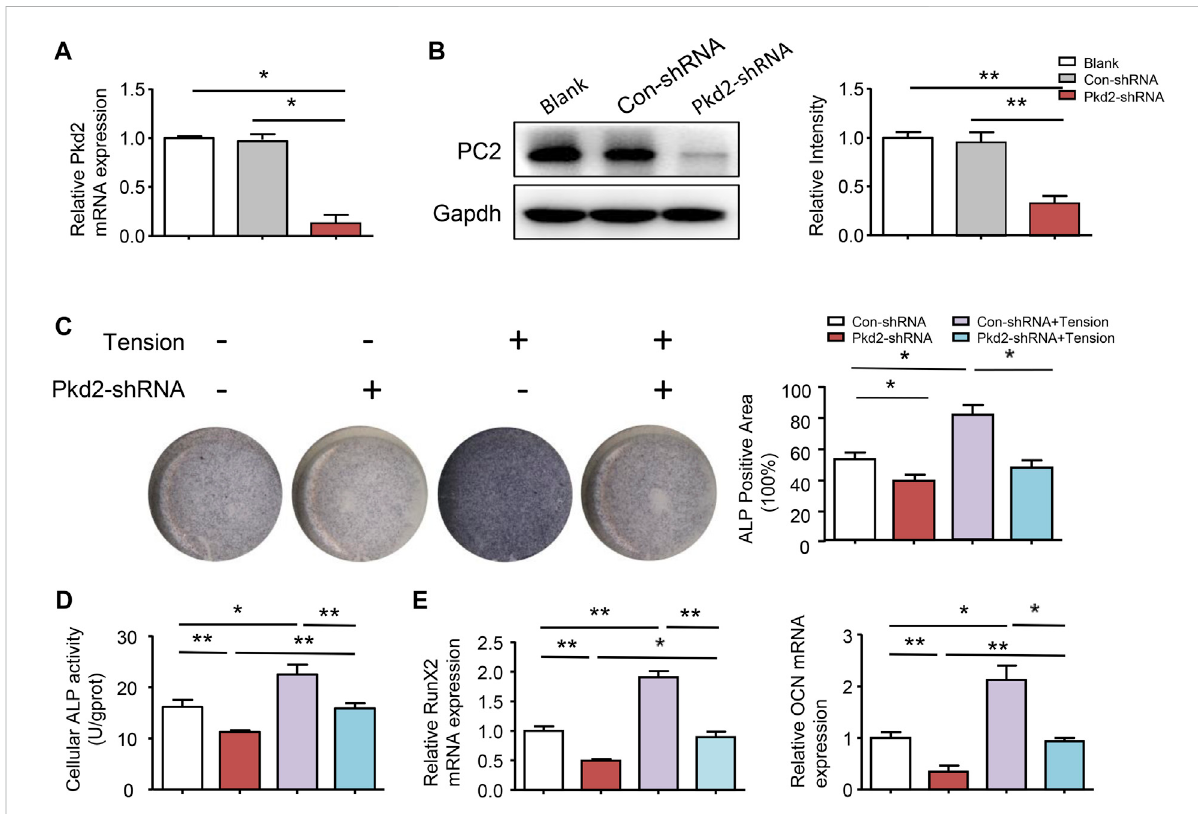
FIGURE 5 PC2 mediated mechanical tension-induced osteogenic differentiation. (A) (B) After treated with PKD2 shRNA, ef fi ciency of lentivirus-shRNA interference was detected by real-time RT-PCR and western blot. (C) After hASCs were treated with Pkd2-shRNA and 5-day ’ s mechanical tension, ALP staining was performed and ALP + areas were measured (D) ALP activity was detected by colorimetric assay (E) After 5-day ’ s mechanical tension, mRNA expression levels of Runx2 and OCN in hASCs transfected with Con-shRNA or PKD2-shRNA were examined by real-time PCR. GAPDH was used for normalization. Values are the mean ± SEM. * p < 0.05, ** p < 0.01. Experiments =